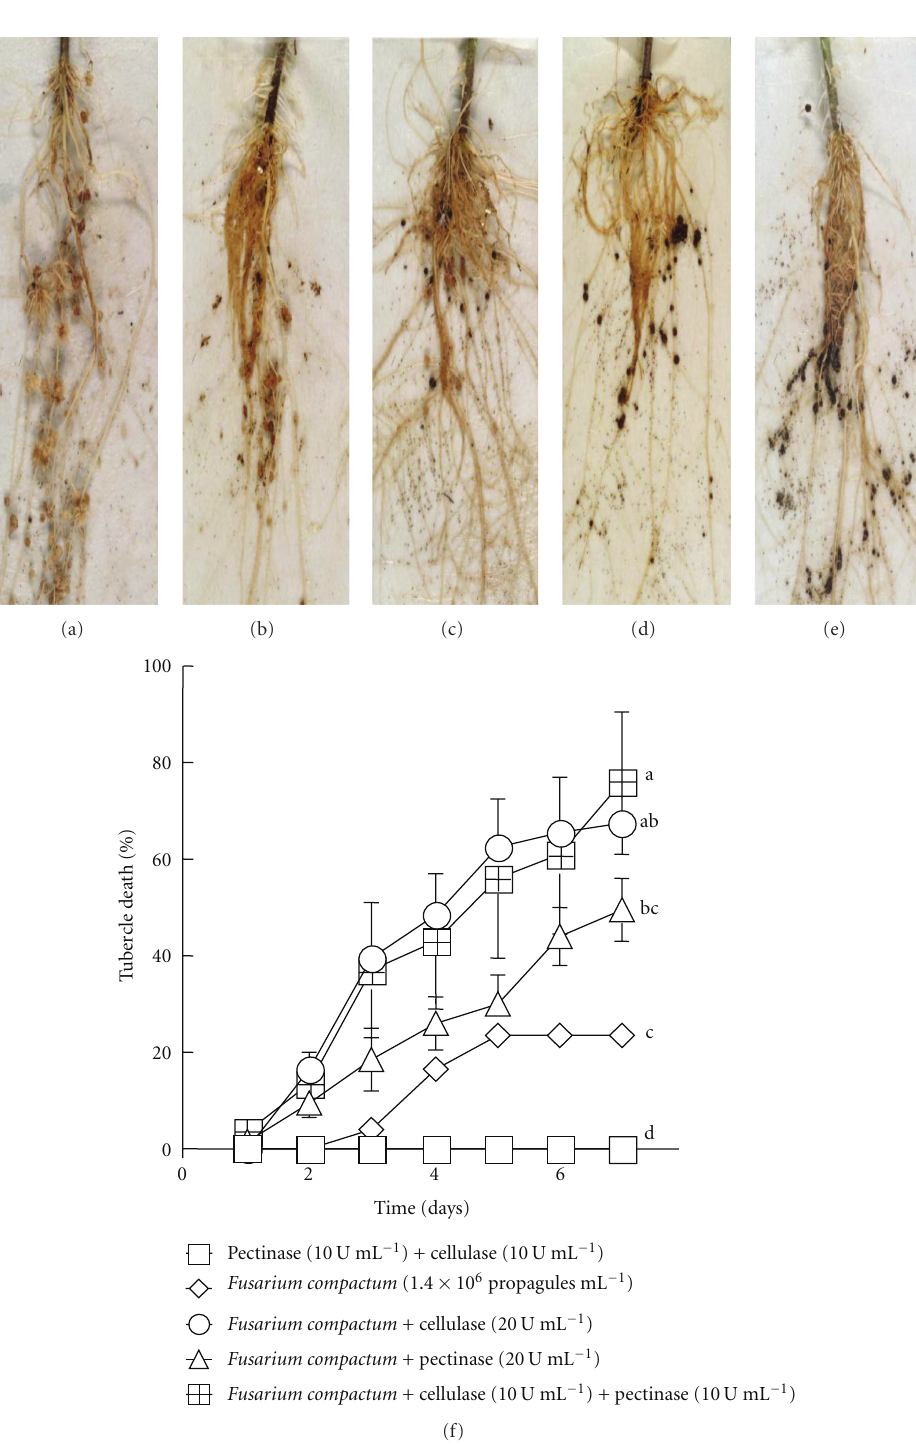
Figure 3: (a)–(e) Adding pectinase and cellulase to chopped F. compactum mycelia enhanced fungal virulence on broomrape. Roots of tomato plants infested with broomrape were sprayed to run-o ff with 10 ml of 10 6 propagules ml − 1 of chopped mycelia in 0.01% Tween 20. (a) A total of 20 U solutions of pectinase and cellulase (1:1) were used as a control treatment. (b) 1.4 × 10 6 propagules ml − 1 homogenized mycelia alone, (c) mycelia plus 20U pectinase, (d) mycelia plus 20U cellulase, and (e) 10U pectinase and 10U cellulase (20U total enzyme) ml − 1 of homogenized mycelial suspension. Each plant bore an average of 35 ± 6 healthy tubercles at inoculation. (f) The graphical representation of (a) to (e). (cid:2) Pectinase (10U ml − 1 ) plus cellulase (10Uml − 1 ), ♦ F. compactum (1.4 × 10 6 propagulesml − 1 ), ◦ F. compactum plus cellulase (20Uml − 1 ), (cid:4) F. compactum plus pectinase (20U ml − 1 ), (cid:5) F. compactum plus cellulase (10Uml − 1 ) and pectinase (10U ml − 1